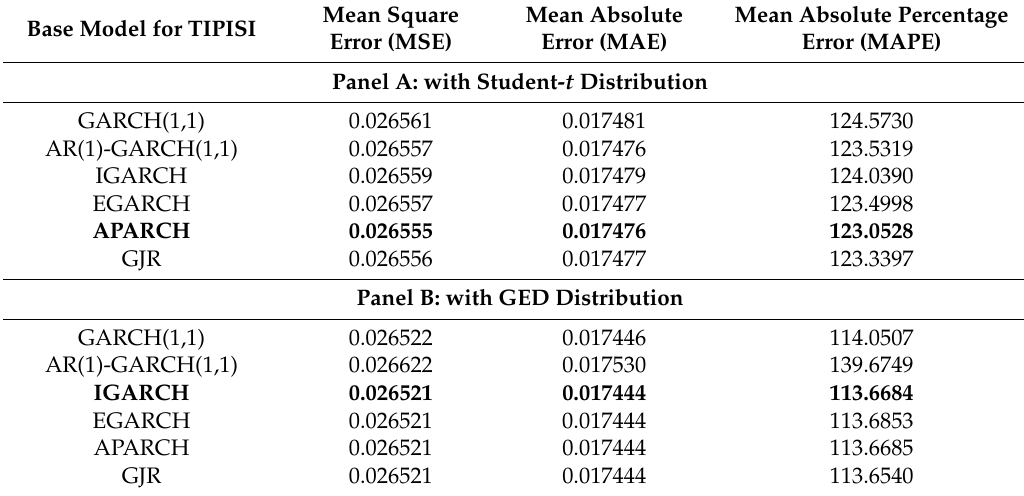
Table 7. Evaluation of one-day out-of-sample volatility forecasts comparison for the TIPISI